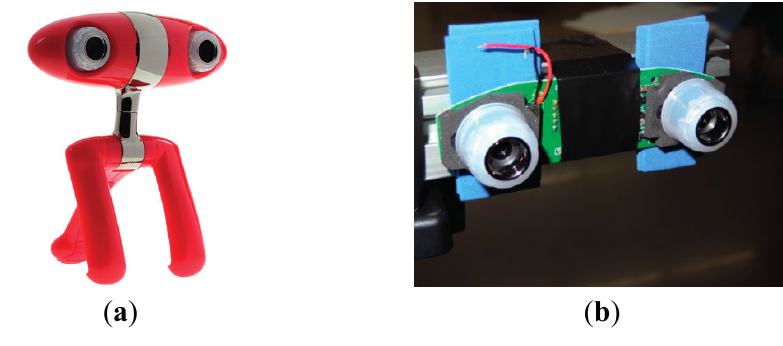
Figure 1. Minoru 3D USB Webcam. ( a ) External view; ( b ) Detail of the two cameras.